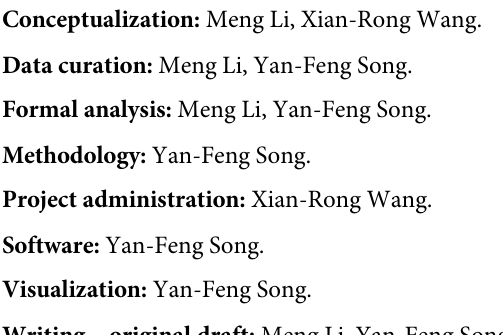
S1 Table. The statistics of nucleotide diversity (Pi) between the species of 20 subg. Cerasus chloroplast genome. S2 Table. Codon features of 20 Subg. Cerasus complete plastomes. S3 Table. Number of analyses of simple sequences repeats (SSRs) in 20 subg. Cerasus com- plete plastomes.